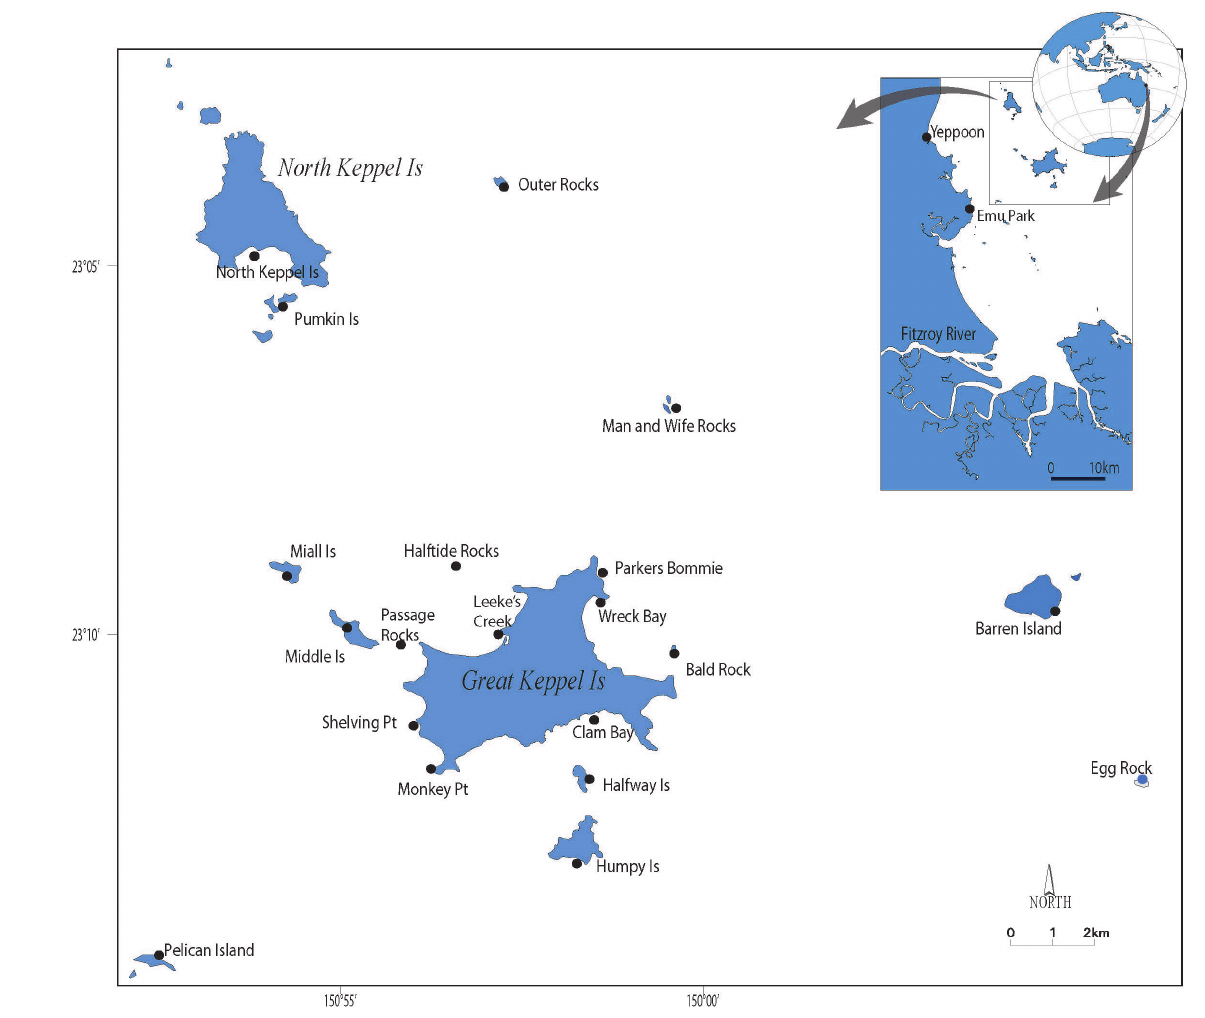
Figure 1. Map of the study sites in the